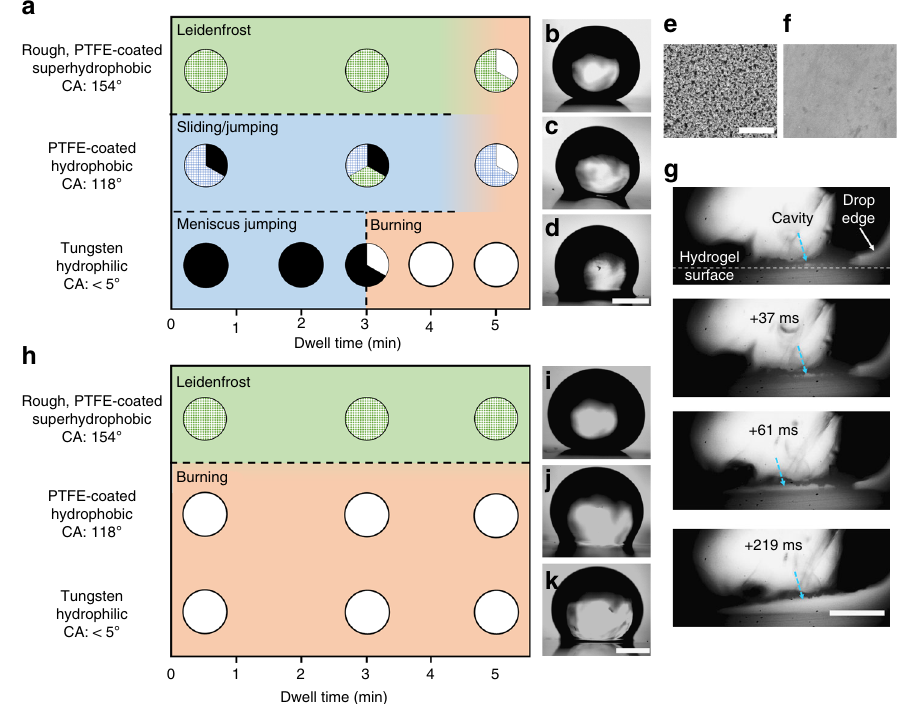
Fig. 3 Effects of surface wettability, dwell time, and modulus on jumping. a Map of outcomes for heating of 25 kPa hydrogels on b superhydrophobic, c hydrophobic, and d hydrophilic surfaces with corresponding optical images before heating. Data are denoted as meniscus jumping ( fi lled), jumping after burning (un fi lled), sliding (blue grid), and Leidenfrost (green diamond). SEM images of ( e ) PTFE-coated TiO 2 surface and ( f ) unmodi fi ed tungsten surface. Scale bar: 3 µ m. g Zoom in of 25 kPa hydrogel and hydrophilic tungsten interface being burned away (greater than 3 min dwell time). The white spot in the center of the hydrogel is re fl ection from light. The white dotted line is the interface between the hydrogel and surface. A cavity (dashed blue arrows) initiates and as the plate temperature continues to increase, the interface forms a vapor layer that separates the drop from the surface. Scale bar: 0.5 mm. h Map of outcomes for 2 kPa hydrogels on i superhydrophobic, j hydrophobic, and k hydrophilic surfaces with corresponding optical images before heating. Scale bar: 1